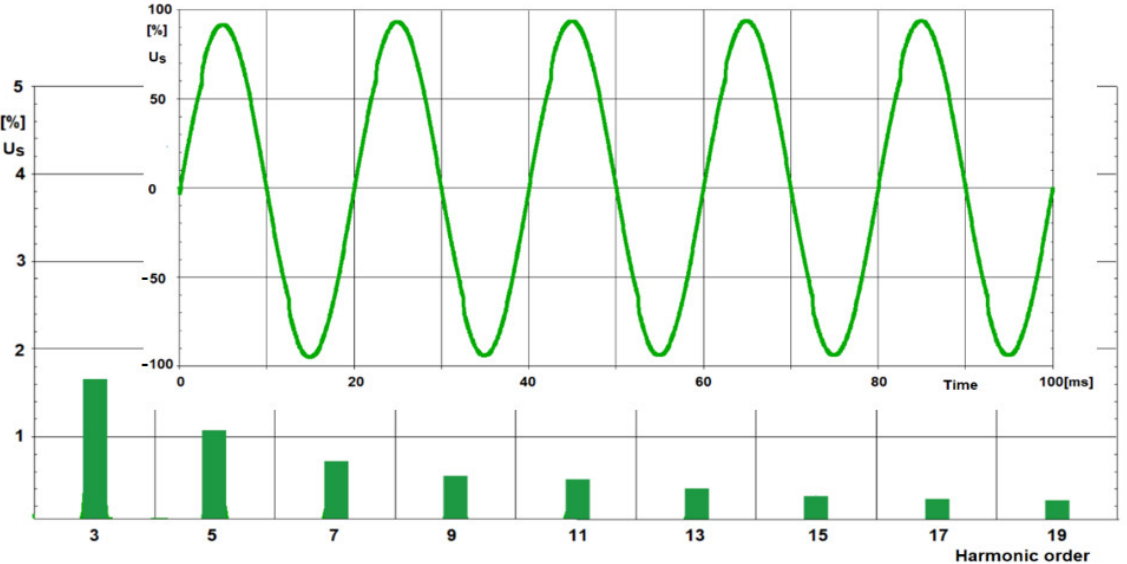
Figure 22. Oscillogram and harmonics spectrum of the supply voltage of the steel plant for S cc / S trc = 134.